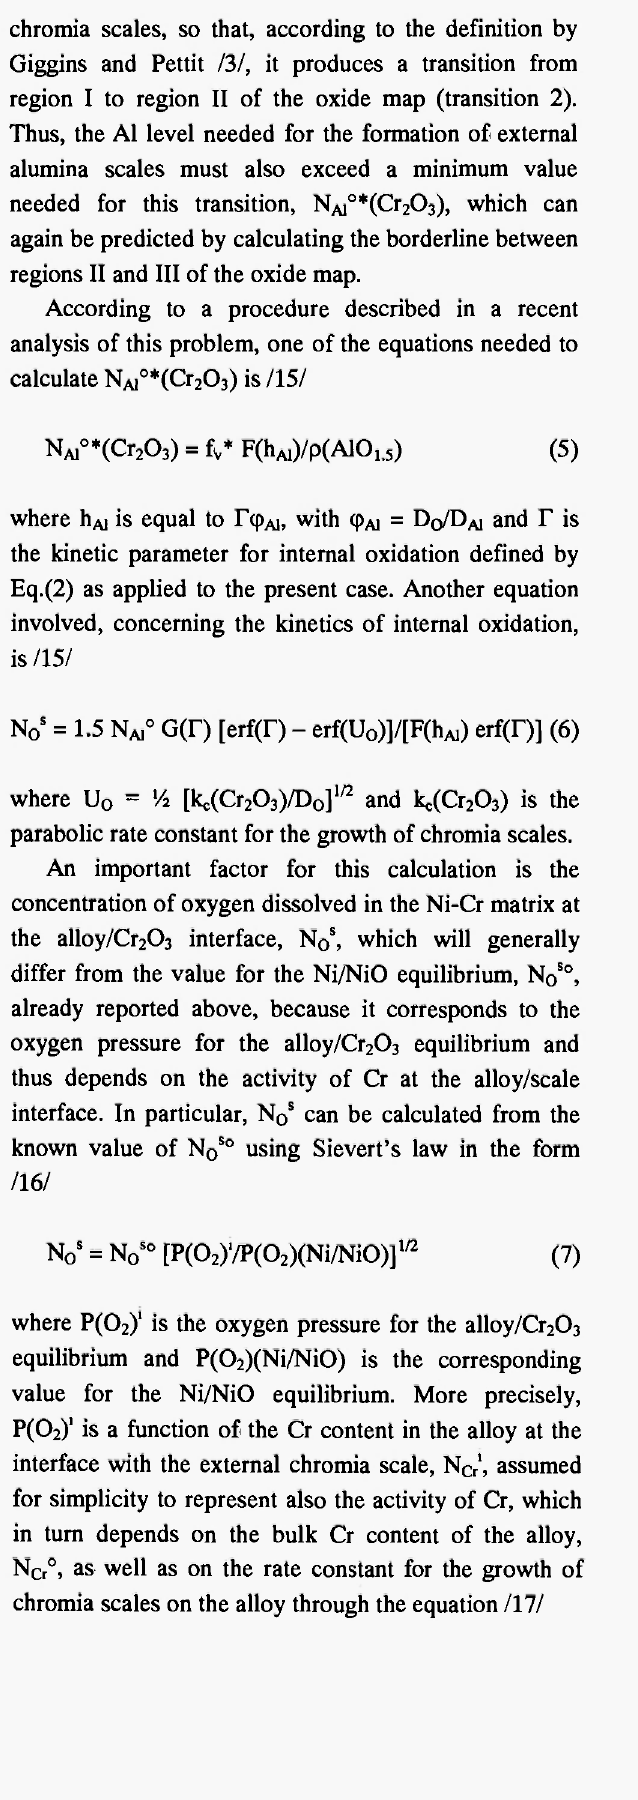
The combination of curves a and b divides the plot of Fig. 3 into three fields, which represent the regions of stability of the coupled internal oxidation of Al+Cr beneath external NiO scales (region I, to the left of